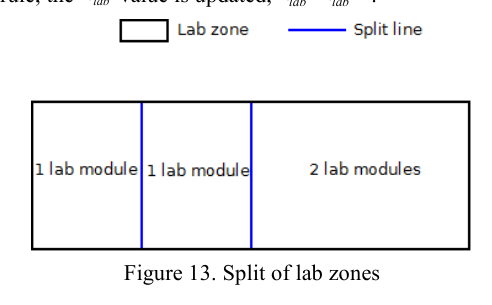
Figure 13. Split of lab